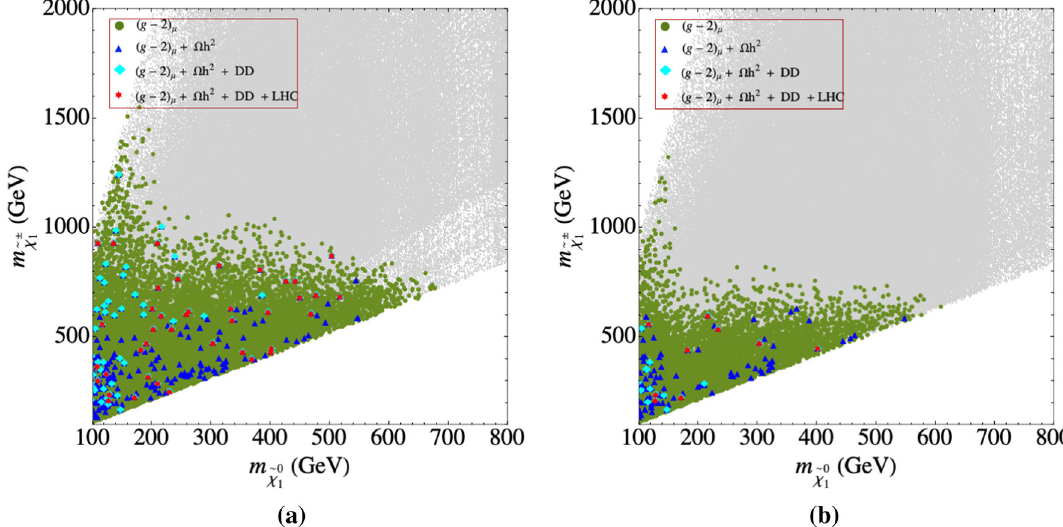
− m plane for the ˜ l ± -coannihilation Case-R (current (left) and anticipated future limits ˜ χ 0 1 1